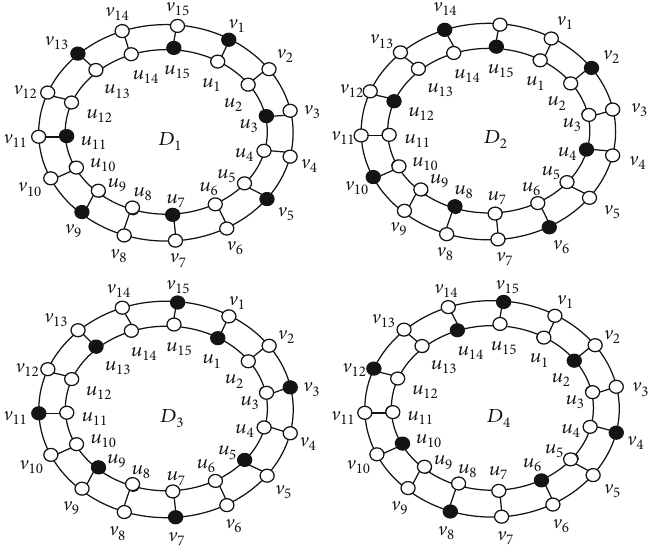
P ð 15, 1 ÞÞ = γ ð P ð 15, 1 ÞÞ = 8 . Figure 4: γ ∞ m ð